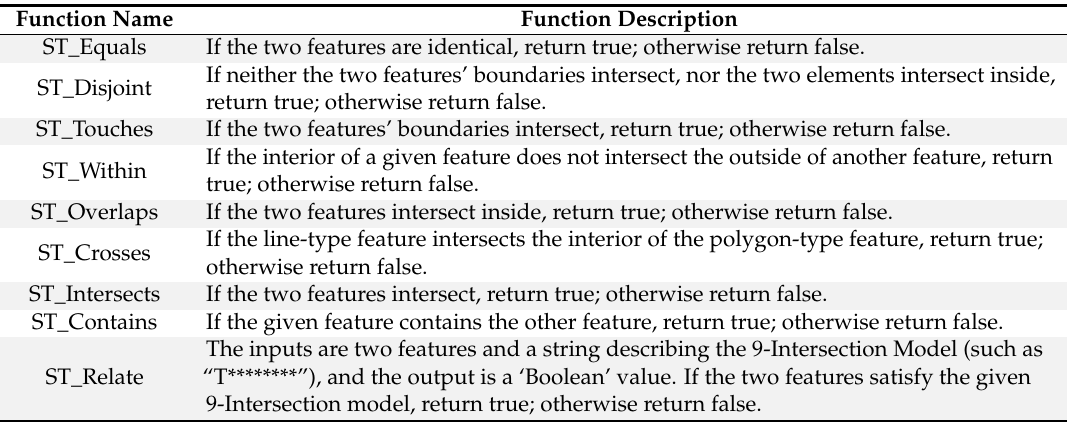
Table 1. Descriptions of extended spatial UDFs in